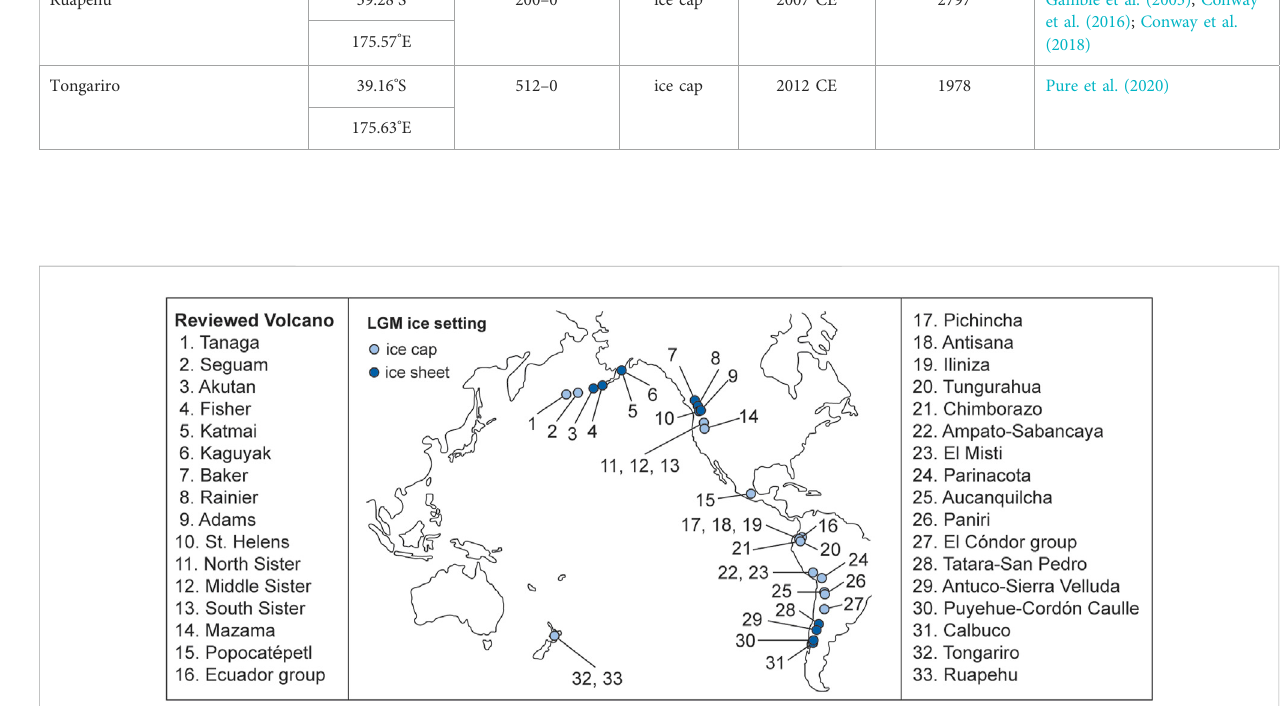
FIGURE 2 Map of circum-Paci fi c arc volcanoes that are assessed in this paper. The numbers refer to the volcanoes and volcanic systems, and LGM ice thicknesses are shown using light and dark blue dots. See Table 1 for the studies that report data on these volcanoes.